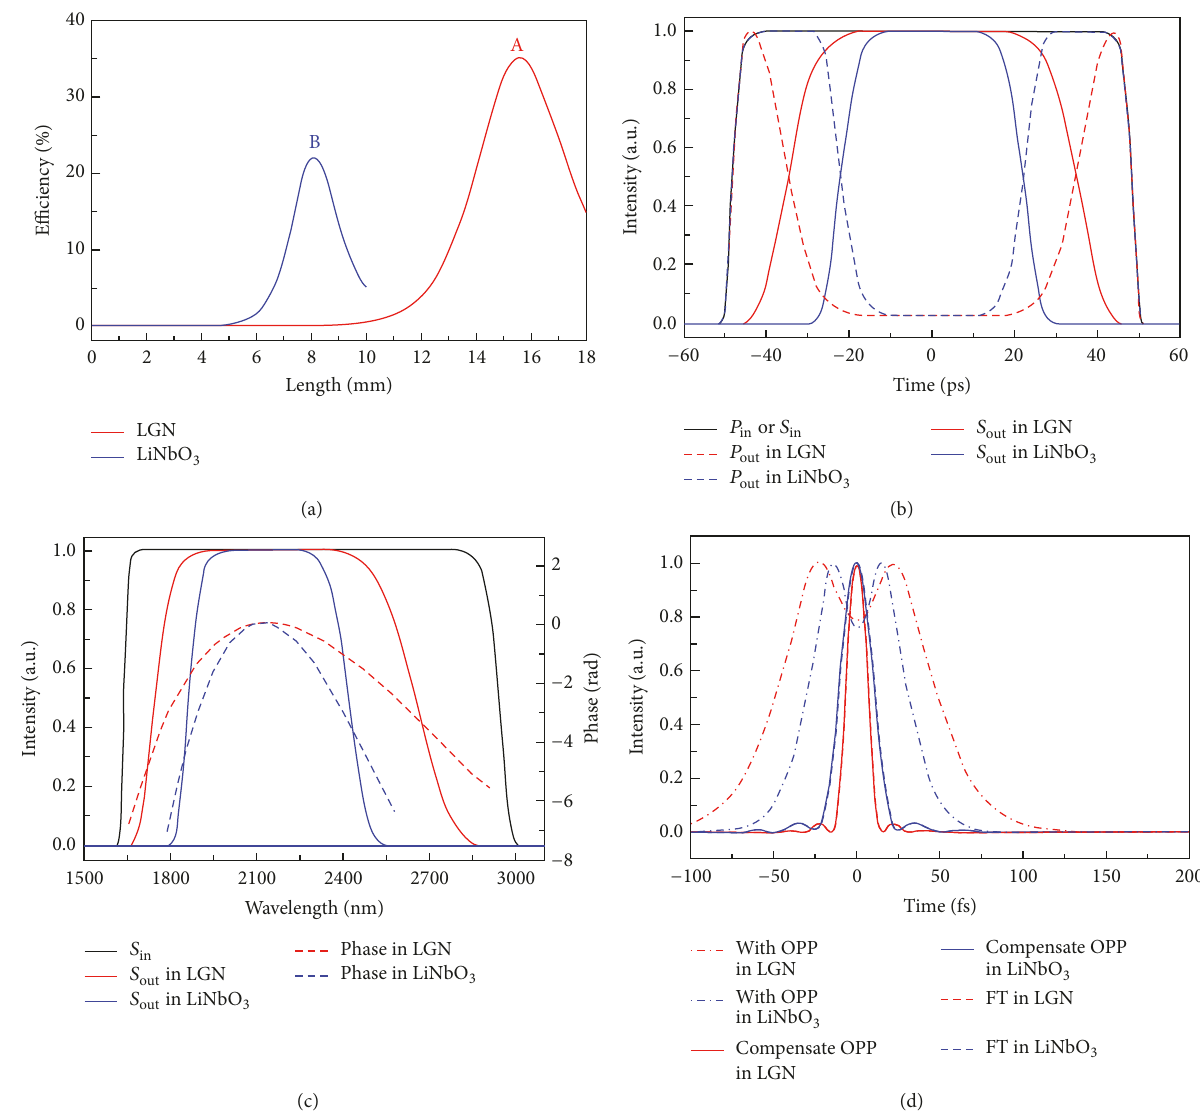
Figure 10: Simulation results for the Type I degenerate OPCPA pumped at 1.054 𝜇 m. (a) Efficiency evolution along the crystal length in LGN (red curve) and LiNbO 3 (blue curve). (b) Temporal profiles of the input pump or chirped signal pulses, the residual pump pulses, and the amplified chirped signal pulses in LGN and LiNbO 3 . (c) Spectra of the input signal and the amplified signals in LGN and LiNbO 3 . The red and blue dashed curves represent the OPP produced in LGN- and LiNbO 3 -based OPCPAs, respectively. (d) The compressed pulses without and with OPP compensation in LGN- and LiNbO 3 -based OPCPAs. The dashed curves represent the corresponding Fourier-transform-limited pulses. Reprinted with permission from [21]. Copyright 2016 Optical Society of